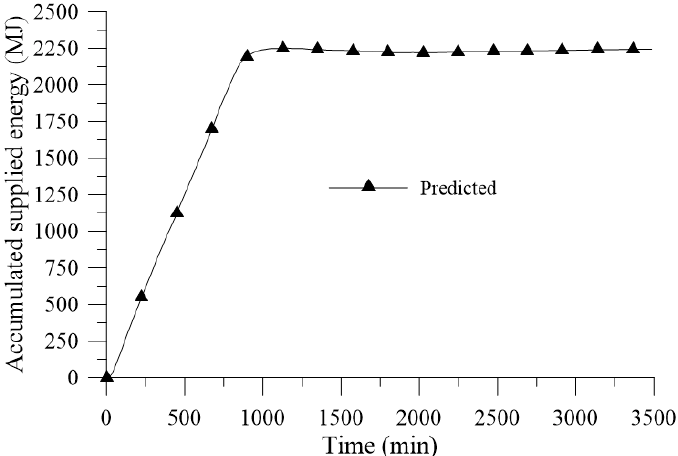
Figure 15. Accumulated energy supplied to the kiln as a function of time.